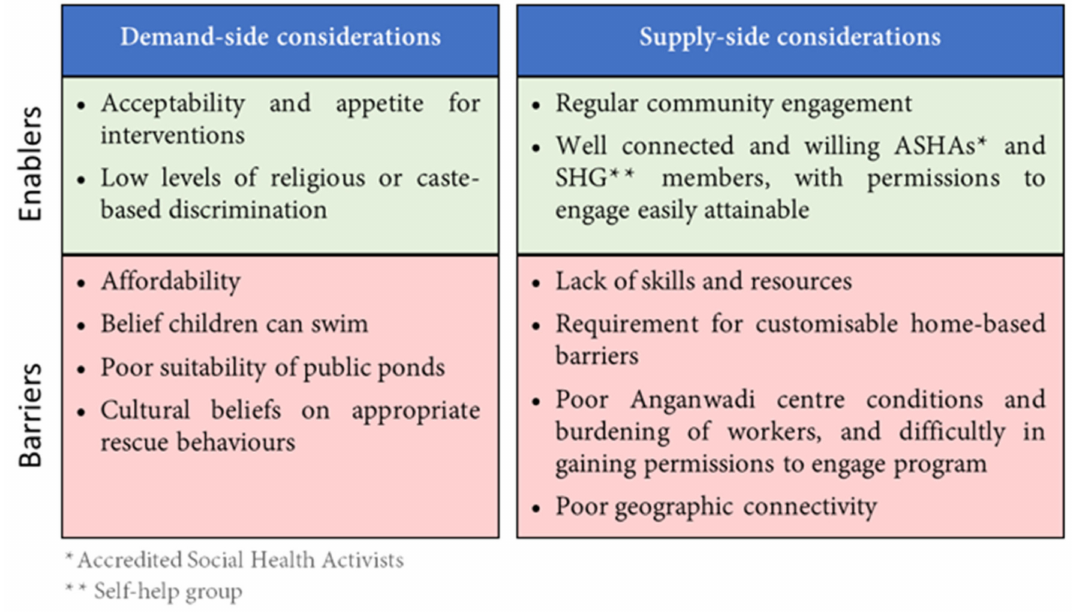
Figure 1. Key contextual enablers and barriers to implementation identified by